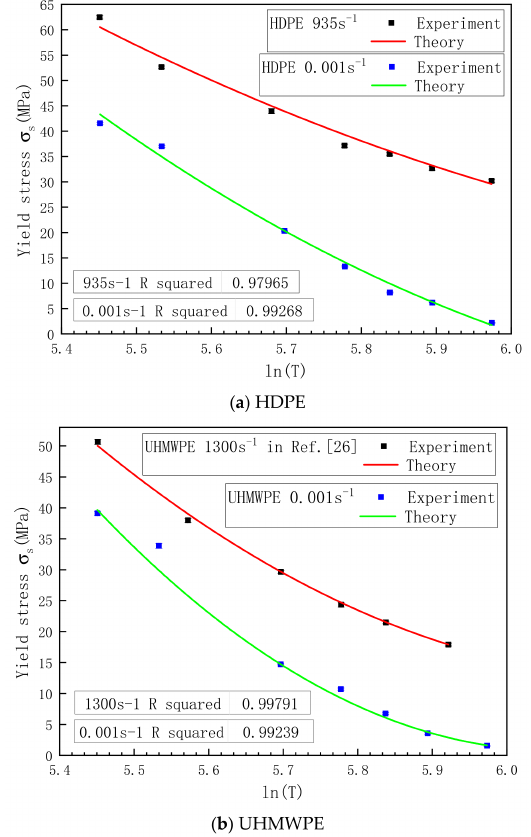
Figure 10. Relationship between the yield stress and temperature for ( a ) HDPE and ( b )